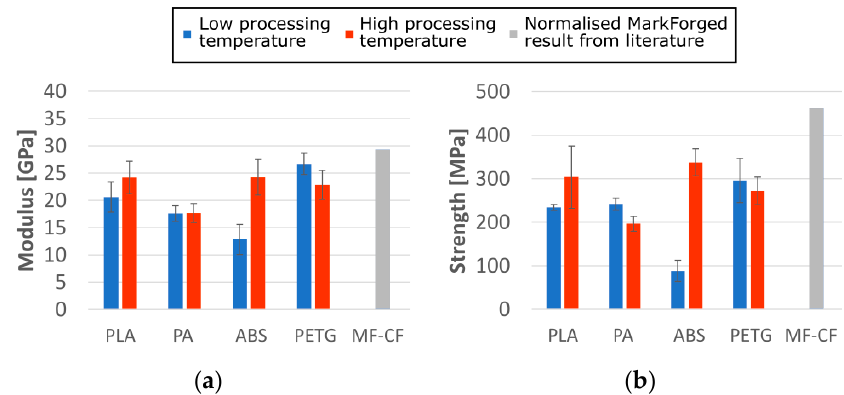
Figure 14. Tensile test results for ( a ) modulus and ( b ) strength of ADFRCs processed at different temperatures as measured compared to MarkForged continuous fibre (MF-CF) printed parts normalized by ratio to a V f of 12.5% [8].